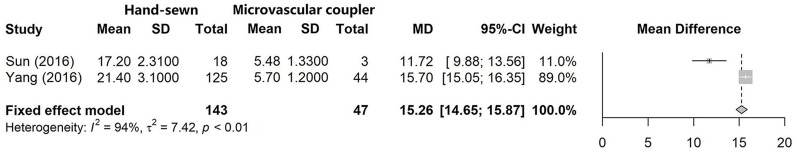
Publication bias as revealed using a Begg’s funnel plot.